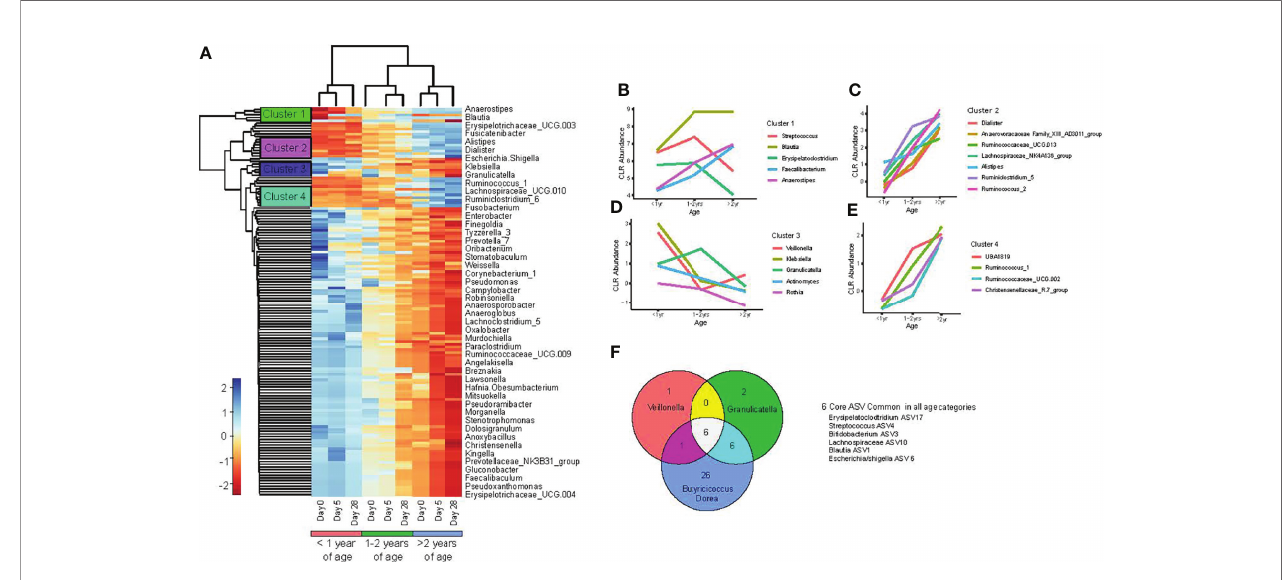
FIGURE 4 | Changes in the gut microbiota occur with increasing chronological age. (A) heat map of bacterial taxa, with signi fi cant interactions between age of study participants and sampling day, as determined by linear mixed model regression; (B – E) mean center log normalized abundances of speci fi c bacteria; and (F) Venn diagram comparison of core ASV between age categories (<1.0 year, 1.0 -2.0 years, and >2.0 - <4.0 years old), determined at study entry (day